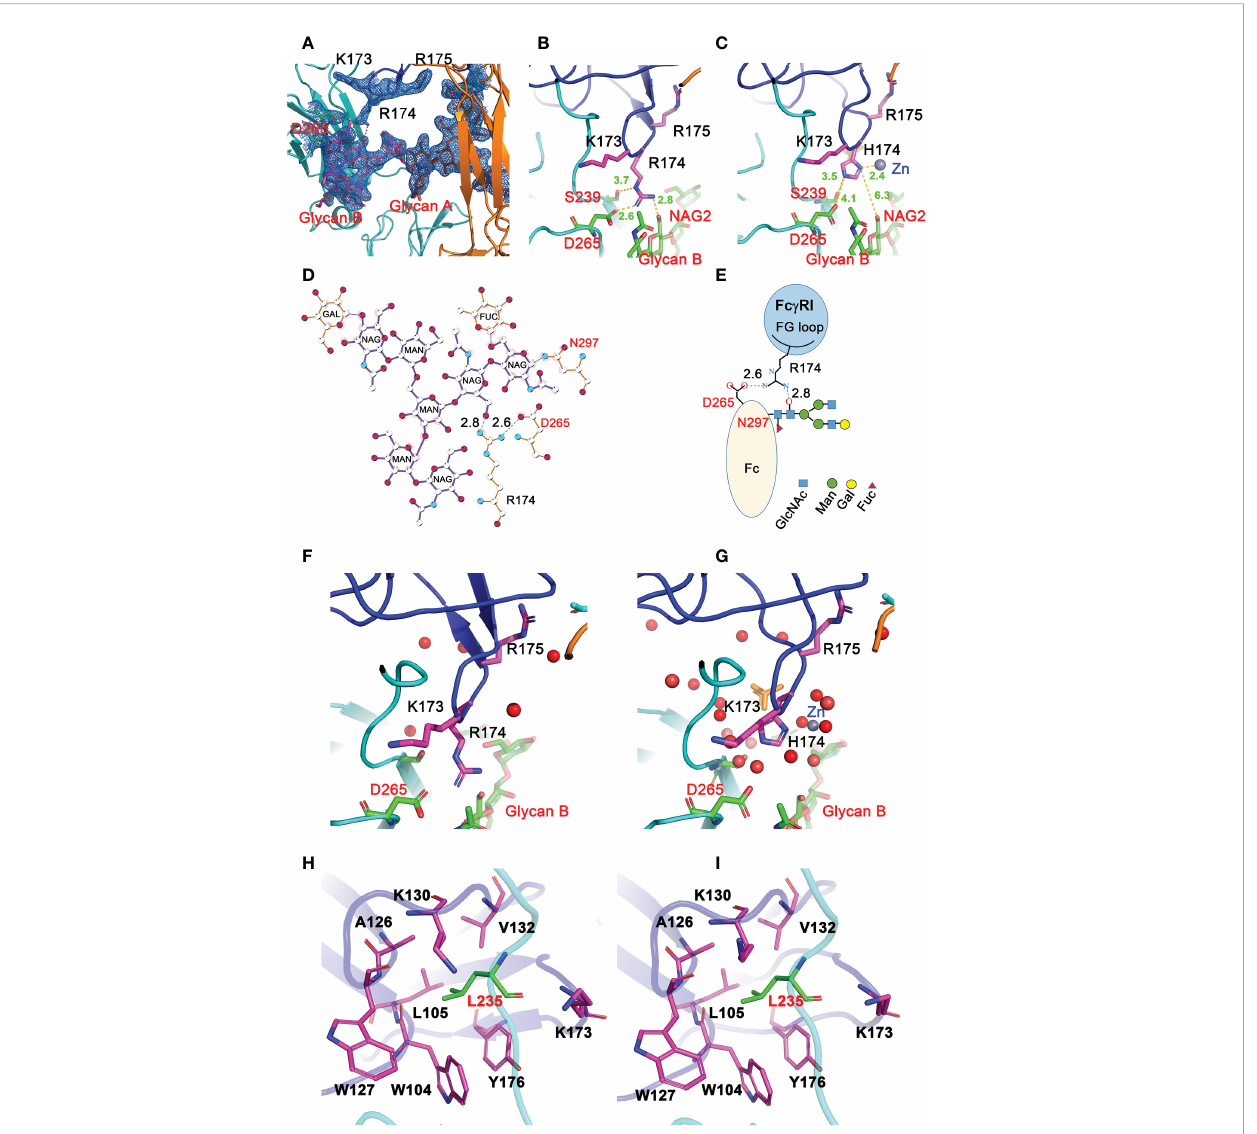
FIGURE 4 Interactions between FG loop and Fc. (A) (2Fo-Fc) electron density map contoured at 1 s showing R174 of Fc g RI forming salt-bridge and hydrogen bond contacts with D265 and glycan, respectively, on Fc. (B) Stick model depicting R174 contacting D265 and glycan on Fc in the H174R variant Fc g RI-Fc complex. (C) H174 in 4W4O is situated too far from D265 and glycan but instead is coordinated by a Zn ion. (D, E) Ligplot and cartoon drawing to illustrate the interactions from R174 of the receptor to D265 and glycans on Fc-B chain. (F, G) interactions between R174 and Fc observed in 8DIR (F) are replaced by water molecules in 4W4O (G) . (H, I) Contacts of Fc-B chain L235 with the receptor hydrophobic pocket as observed in 8DIR (H) and 4W4O (I)